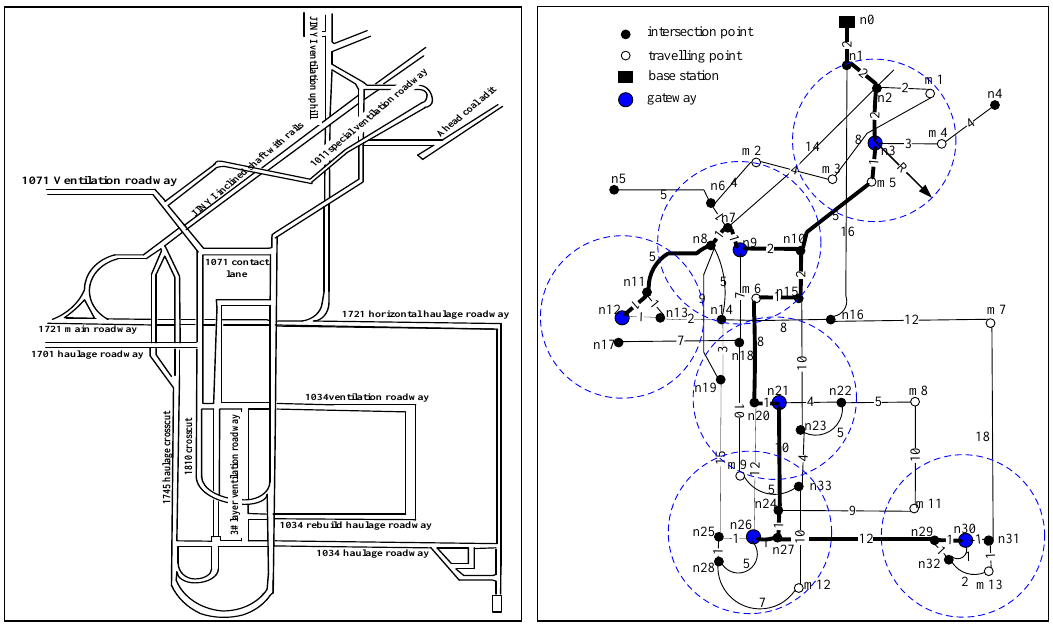
Figure 2. Tunnel network topology and backbone network deployment.